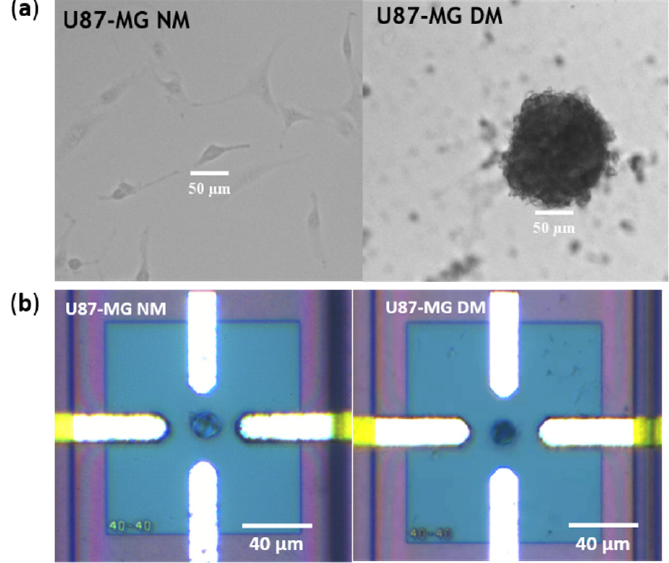
Figure 7. ( a ) Microscope view of the U87-MG cell line cultured in two different conditions: Normal Medium (NM) and after 2 days in define medium (DM); ( b ) microscope view of characterized U87-MG cell line trapped in our quadrupole sensor.